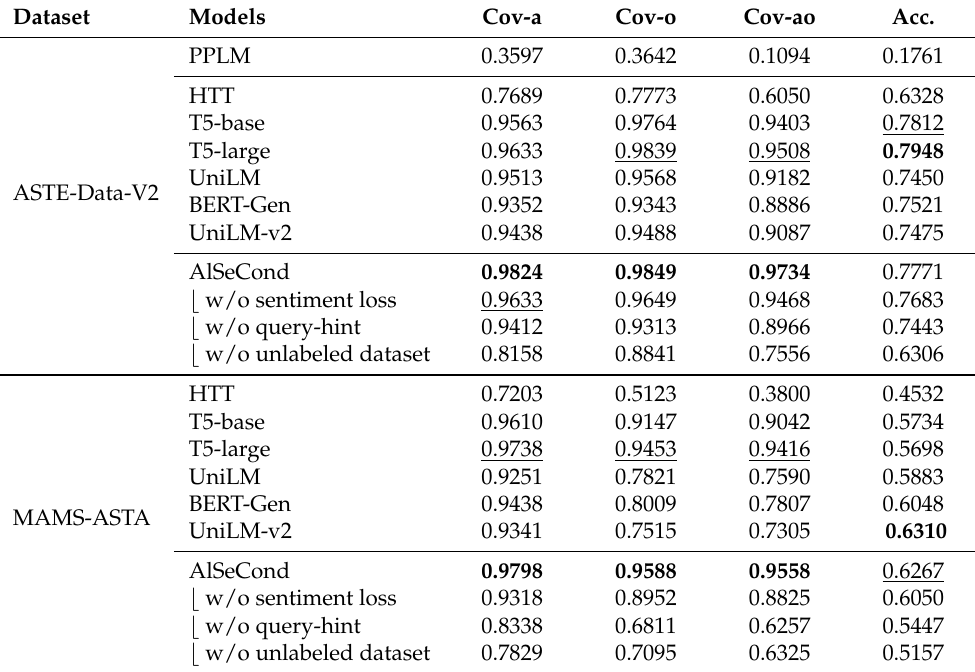
Table 3. Results for the sentiment evaluation. Note that Accuracy (Acc.) is a rate indicating how many fine-grained sentiments are accurately expressed in the sentence, and it is automatically evaluated by an external classifier.